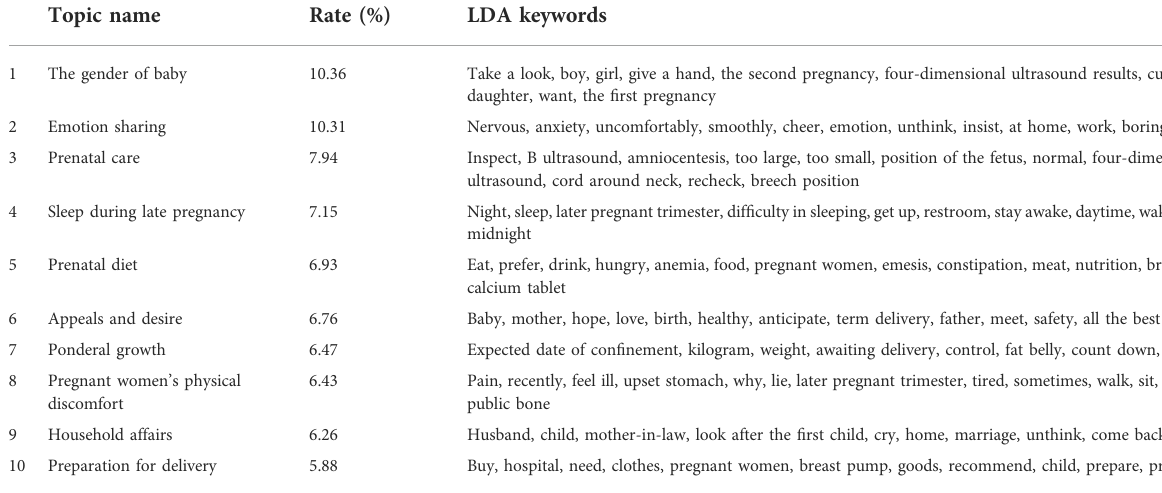
TABLE 11 Topics in the eighth month of